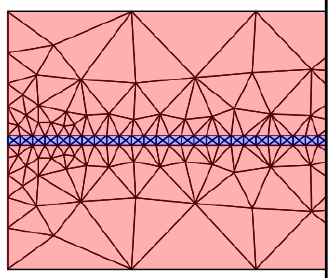
Figure 4. Finite element mesh: glass domain in red and the interlayer in